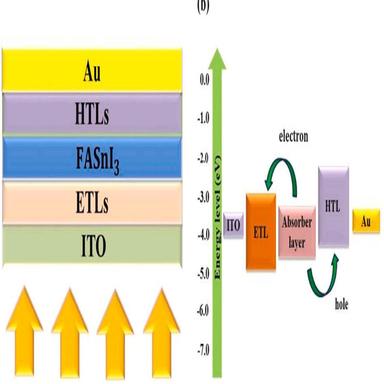
(a) Architecture of PSCs (b) Energy level diagram of different layers.